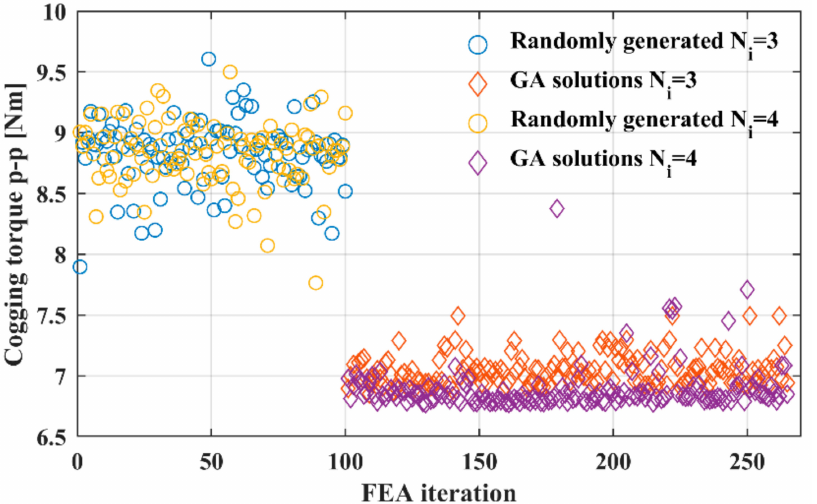
Figure 11. Objective function values computed using the TWM FEA performed during the heuristic procedure on the APMM with 20 stator segments and N i = 3,